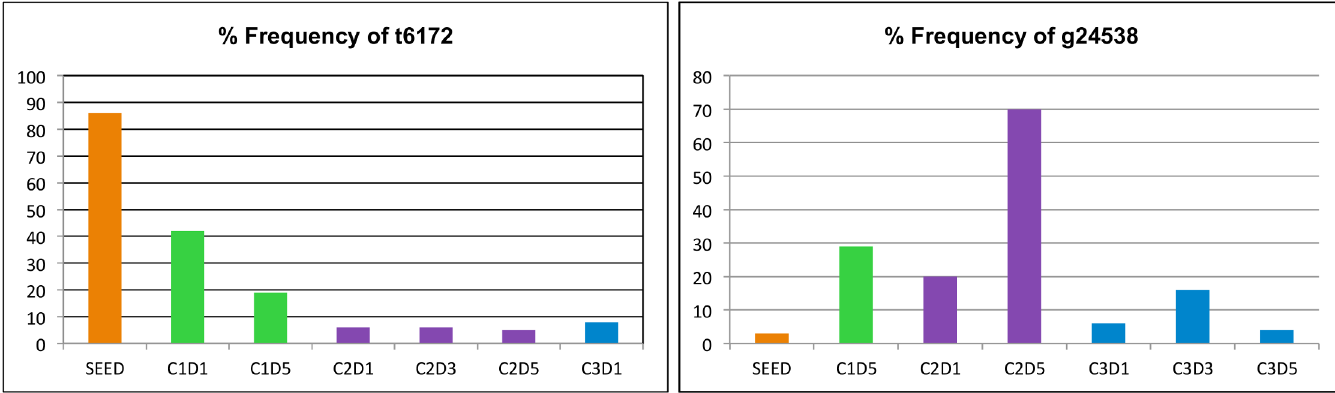
Fig 2. Histogram of high frequency iSNVs resulting in a nonsynonymous change in the consensus sequence of one or more samples. The iSNV detected at site t6172, caused a Phe to Ser mutation in nsp 3 residue 1965 and resulted in a consensus change that differentiated the camel genotypes from that of the Seed. An iSNV, g24538, was present at low frequency in the Seed stock but increased in frequency during propagation in camels with a change in consensus sequence occurring in C2D5, resulting in an N1028S mutation. Note, only data from samples with adequate coverage at the relevant iSNV position were included in the